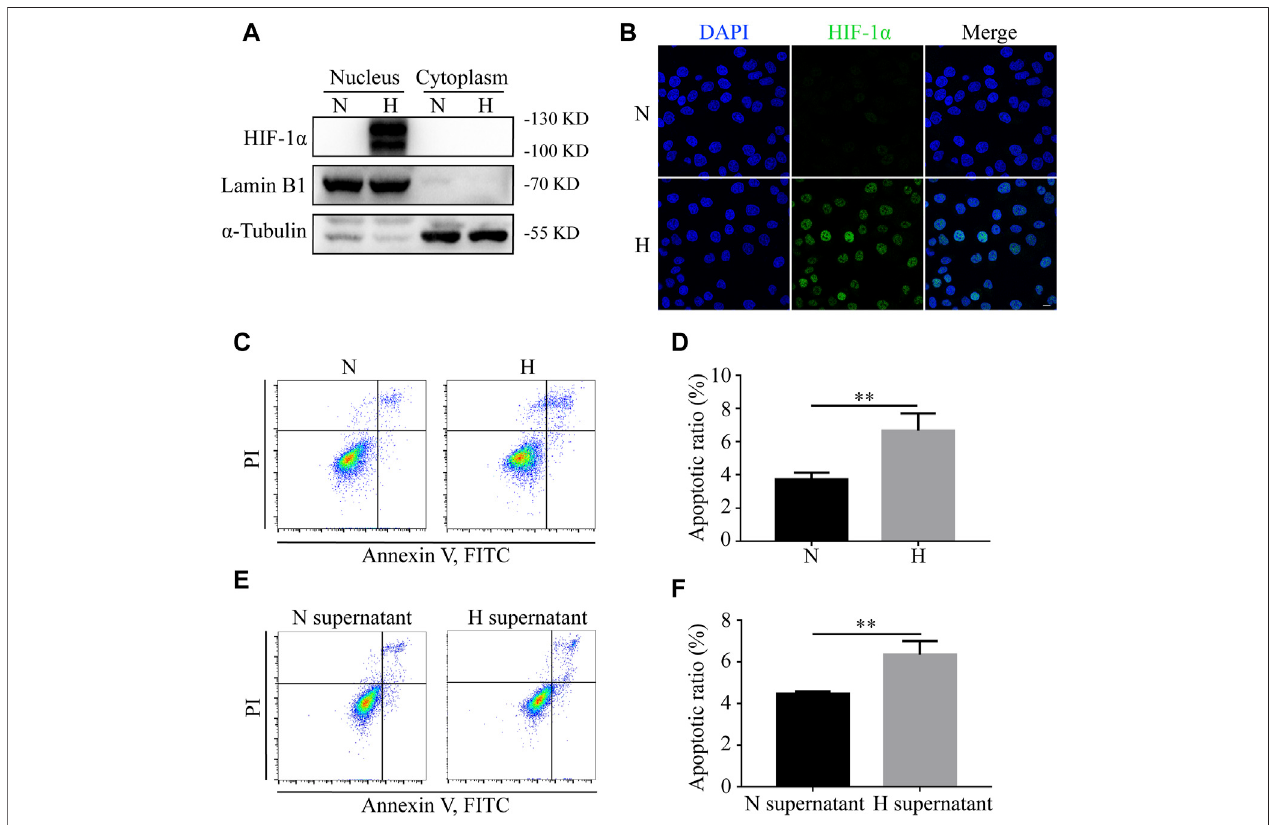
FIGURE2| HypoxiaandhypoxicsupernatantpromoteapoptosisinnormoxicHIECcells. (A) Westernblottingand (B) IFdetectionofthelevelsofHIF-1 α innuclear andcytoplasmicfractionsofHIECcellsundernormoxiaorhypoxia. (C,D) FlowcytometryinvestigationofapoptosisofHIECcellsundernormoxiaorhypoxia. (E,F) Flow cytometry investigation of apoptosis of HIEC cells cultured in normoxic or hypoxic HIEC cell supernatant. Scale bar: 10 μ m. N, normoxia; H, hypoxia; N supernatant, normoxic supernatant; H supernatant, hypoxic supernatant. ** p < 0.01, *** p < 0.001.